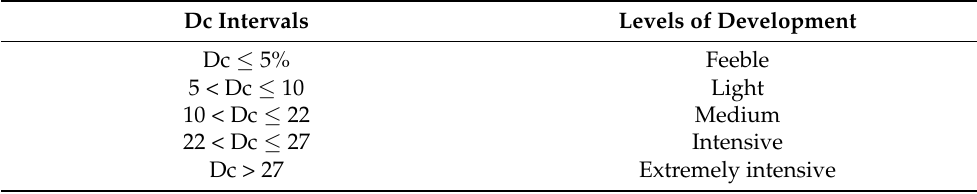
Table 1. Soil cracks’ level of development based on the crack area density.